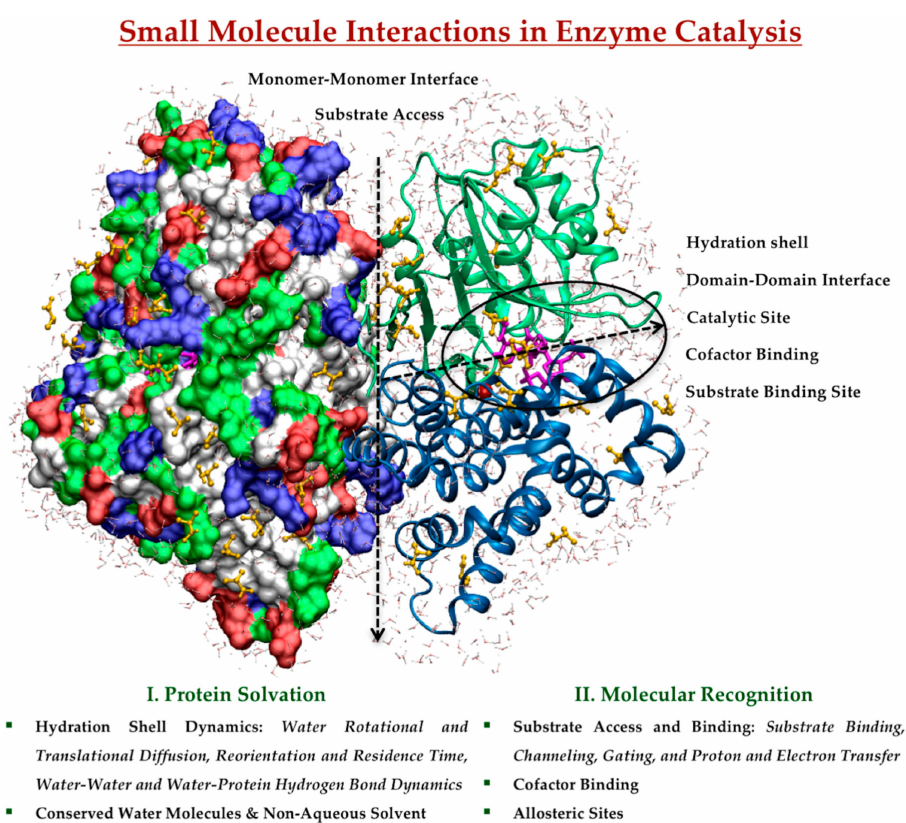
Figure 1. Small molecule interactions with protein are illustrated based on their involvement in ( I ) protein solvation and ( II ) molecular recognition using a model protein, YqhD aldehyde reductase (PDB ID: 1OJ7 [55]). The dotted arrows show the monomer and domain interfaces in the YqhD homodimer. The monomers are in a surface representation colored by residue type, and in a cartoon representation with the domains colored in blue and green, respectively. The encircled region includes reduced nicotinamide adenine dinucleotide phosphate (NADPH) and zinc ion cofactors, and isobutyraldehyde substrate binding in the catalytic site. Substrate and water molecules within 3.5 Å of protein represent the hydration shell and substrate binding on the protein